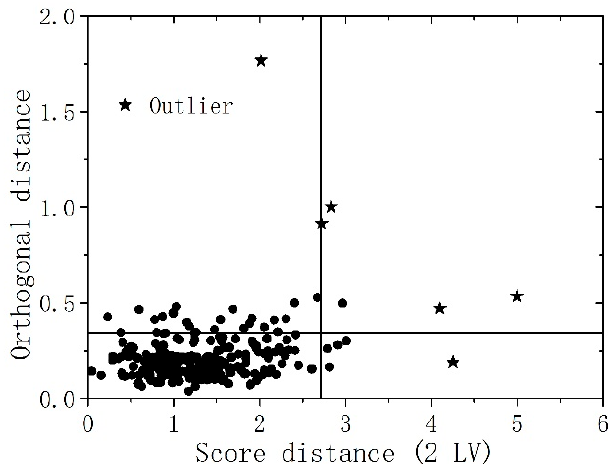
Figure 2. Scatterplot of soil reflectance spectra detected using robust principal component analysis method based on two principal components. The vertical and horizontal lines in the plot are the cutoff values of orthogonal and score distance obtained from robust principal component analysis (ROBPCA) to detect outliers, and the Star symbol refers to the outliers.